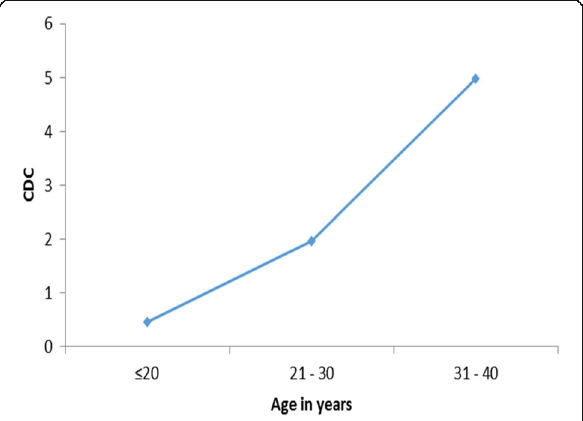
Fig. 1 Comparison of age and mean values of CDC